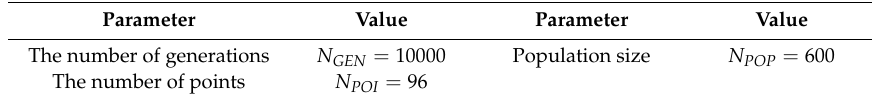
Table 3. Parameters of Algorithm 2 in Figure